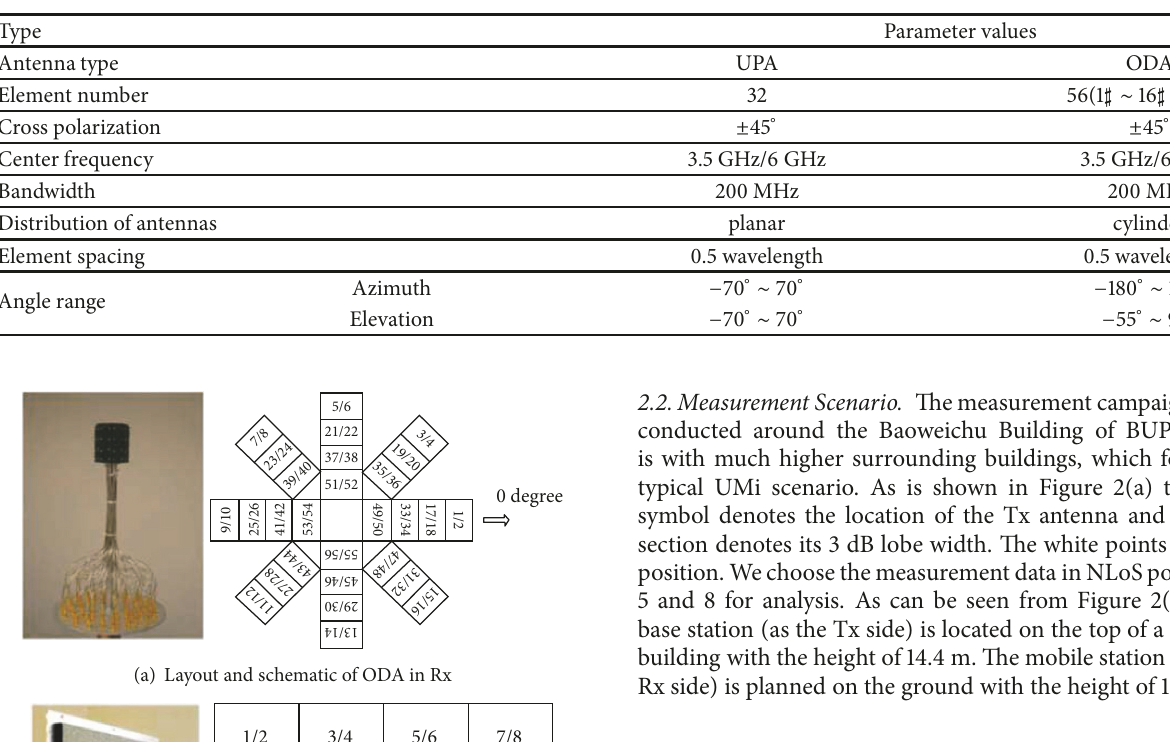
Table 1: Antenna configuration.